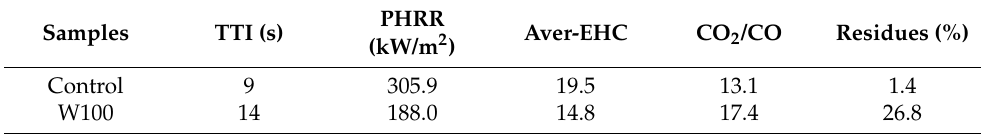
Photos of the control ( e ) and the PBTCA-treated wool ( f ) after the cone calorimetry test. Table 1. Results of cone calorimetry for the control wool and the PBTCA (100 g/L)-treated wool.